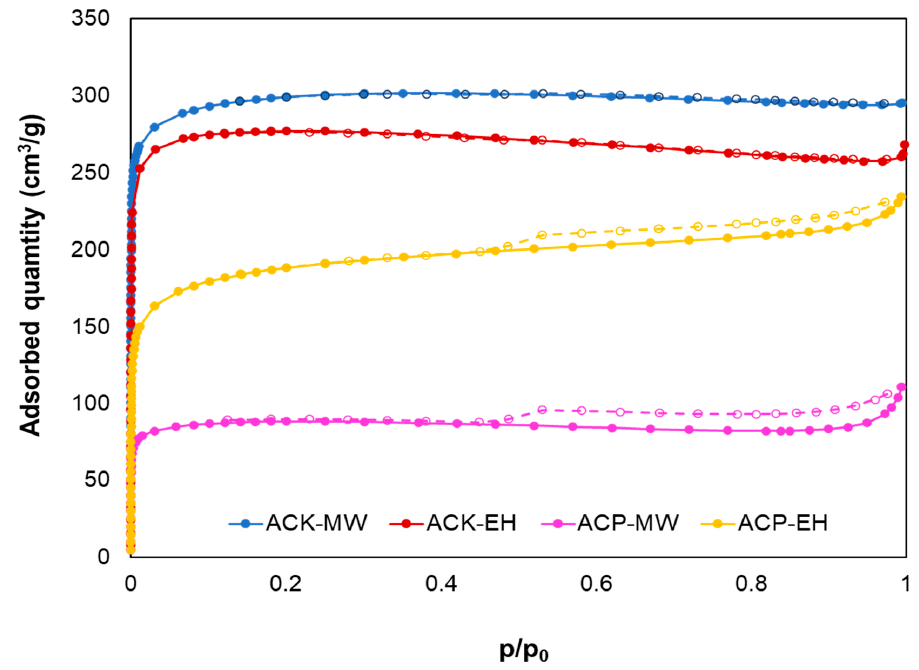
Figure 2. N 2 adsorption–desorption isotherms of prepared activated carbon.